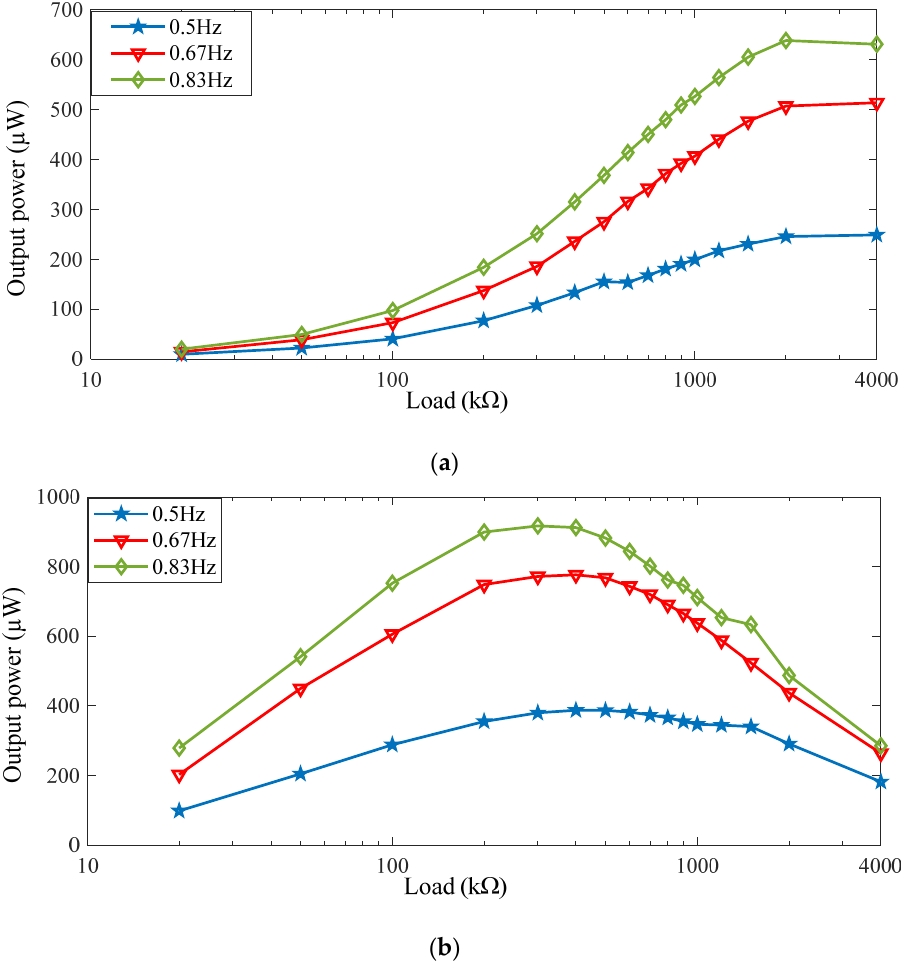
Figure 14. Output power of piezoelectric elements with different loads and step frequencies: ( a ) four piezoelectric elements in series; ( b ) four piezoelectric elements in parallel.